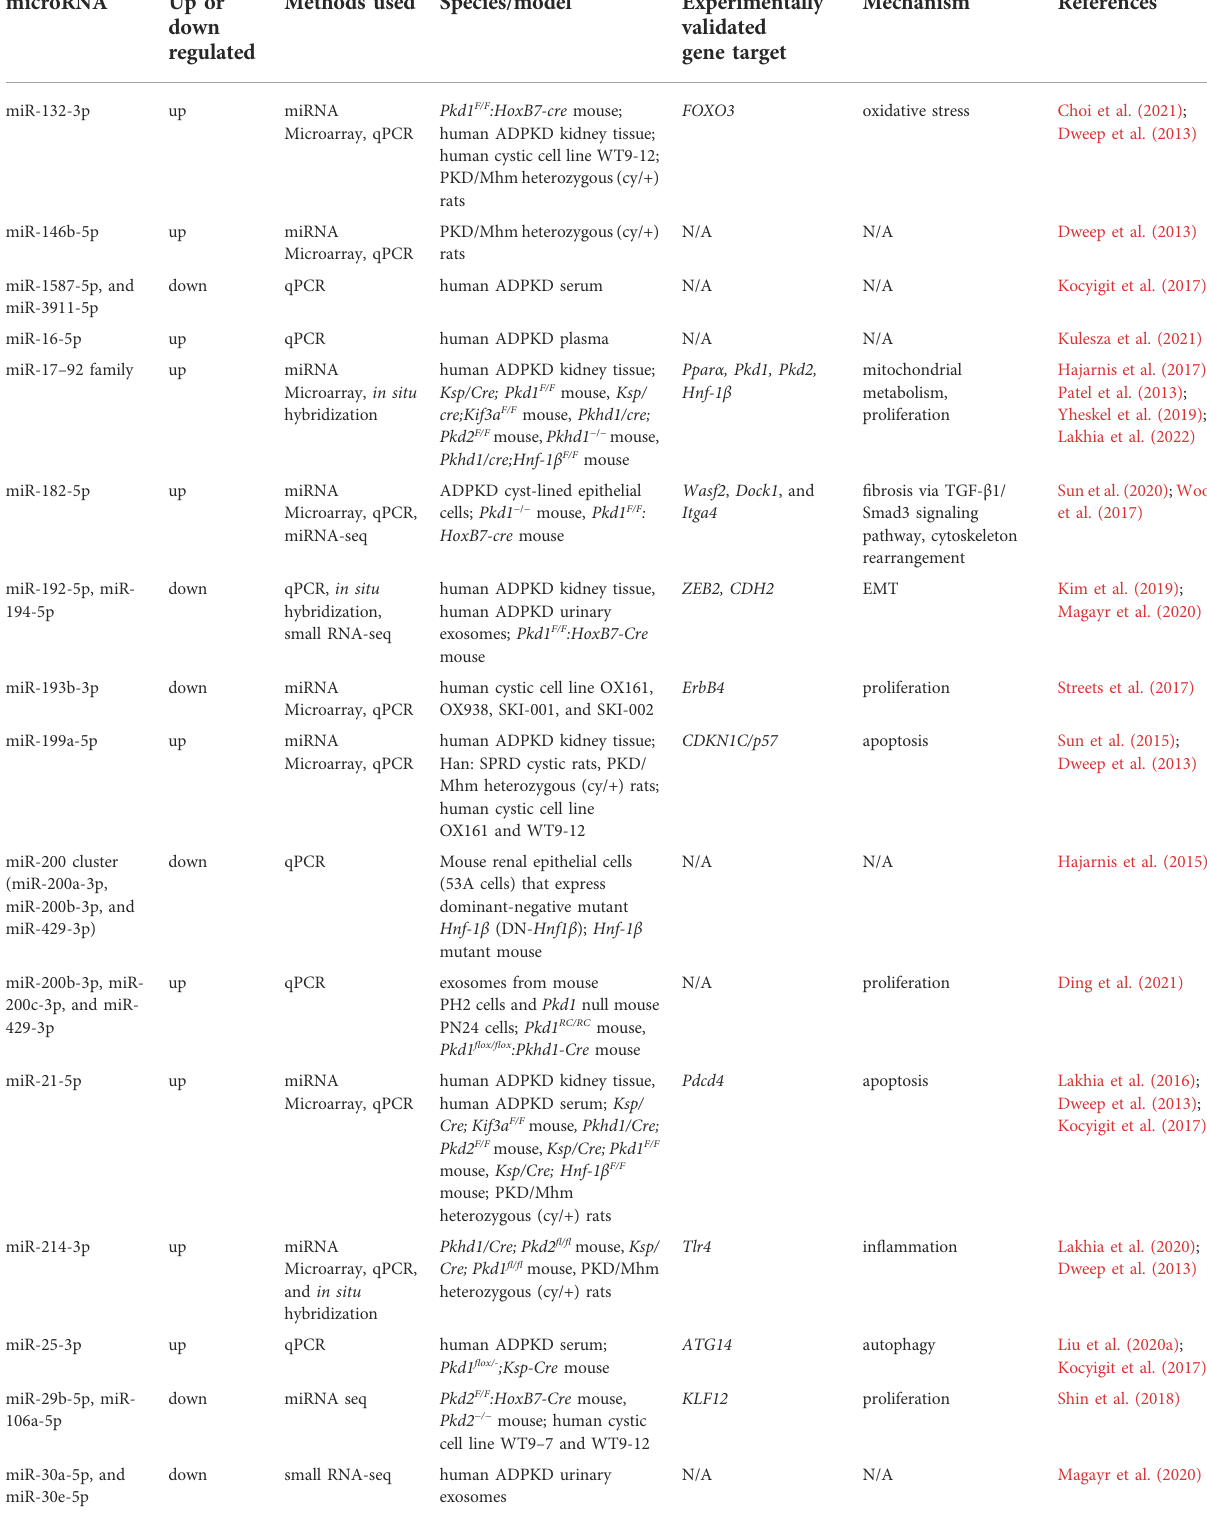
TABLE 1 A summary of published dysregulated miRNAs in Polycystic Kidney